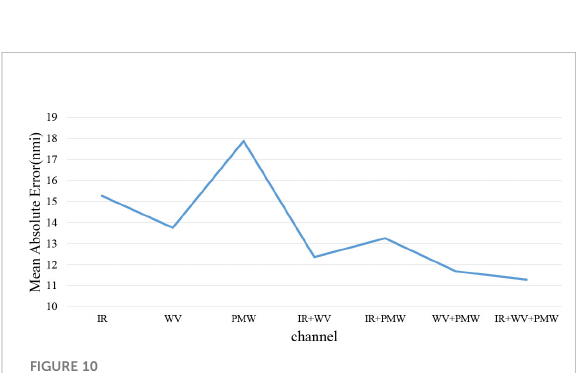
FIGURE 10 Performance of different channels of satellite data and their combinations.